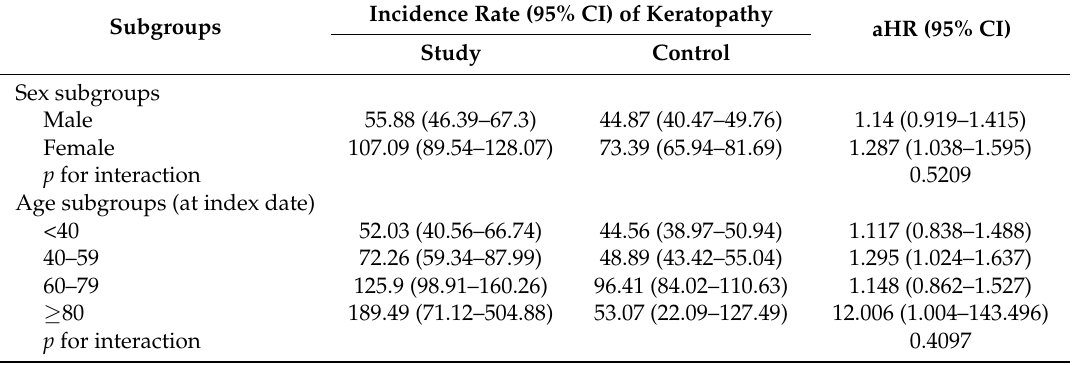
Figure 2. The cumulative probability of keratopathy between the study and control groups. Table 4. The sensitivity analysis for the adjusted hazard ratio stratified by sex and age groups.